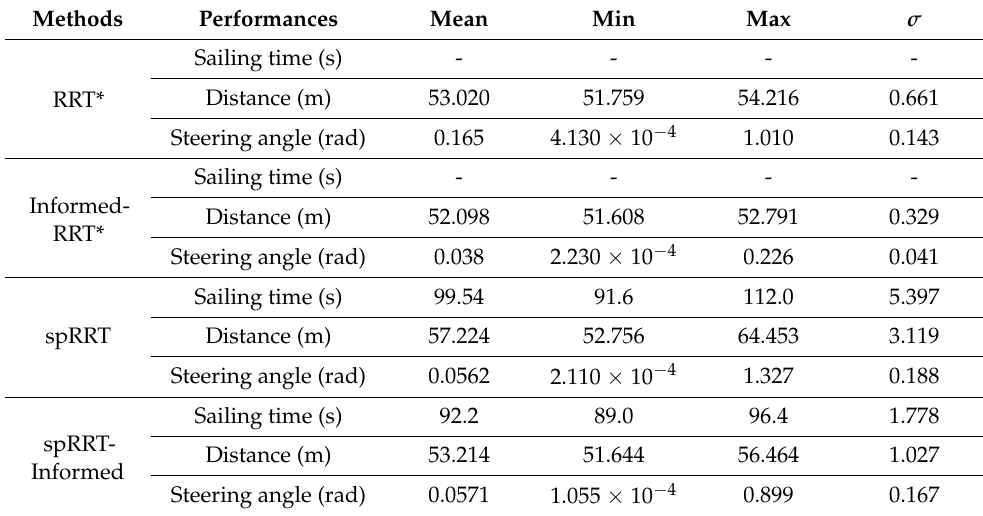
Table 4. Path characteristics parameters under scenario 3.